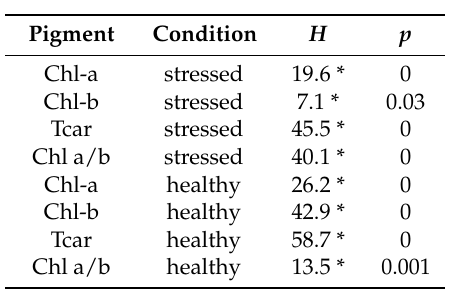
Comparing the samples from the Avicennia germinans , Laguncularia racemosa , and Rhizophora mangle , mangrove species using a Kruskal–Wallis H -test for the pigments ( n = 30) during the dry season. * Significant H calculated value at α = 0.05.